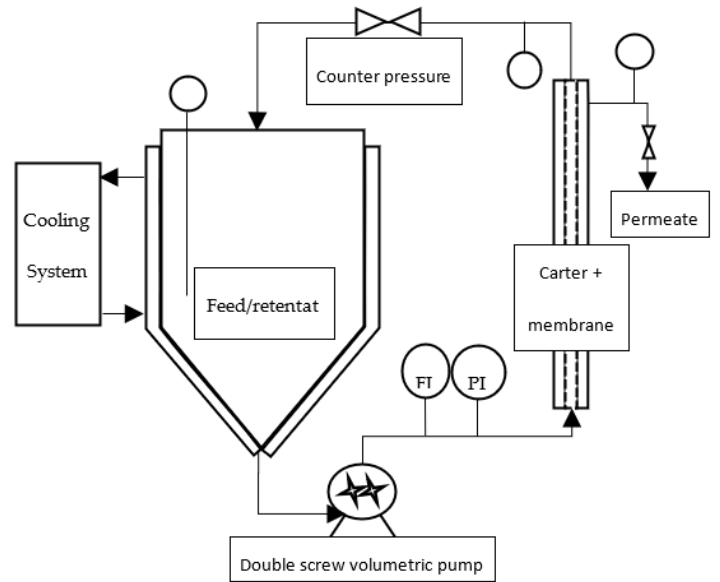
Figure 2. Filtration pilot design (FI: flow indicator; PI: pressure indicator).